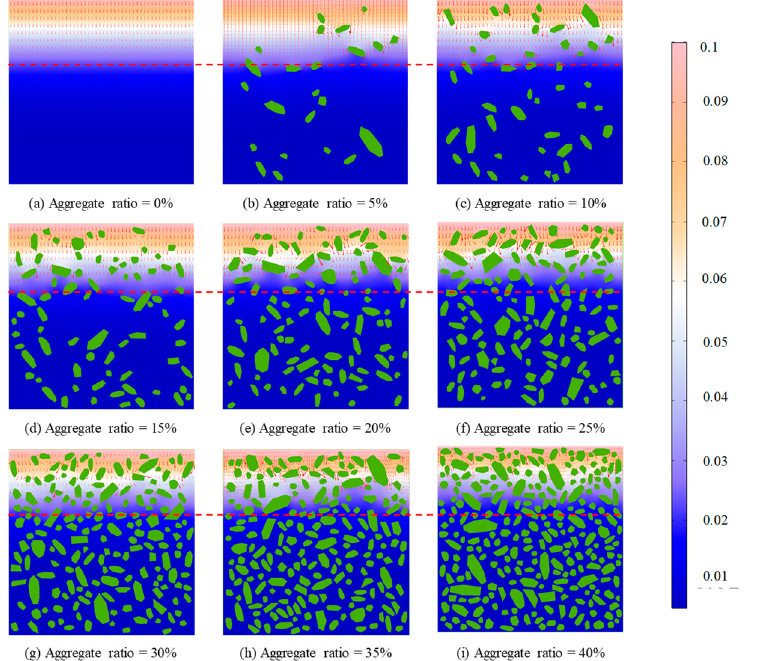
Figure 6. Chloride concentration distribution for different coarse aggregate rate conditions. 1.52 1.51 1.40 1.40